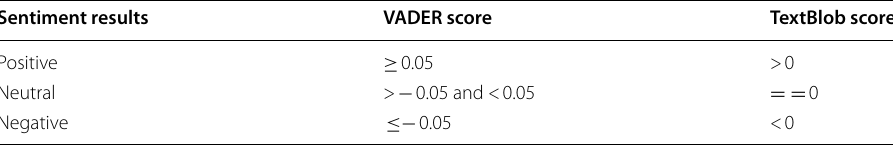
Table 2 Table showing the sentiment score algorithm Sentiment